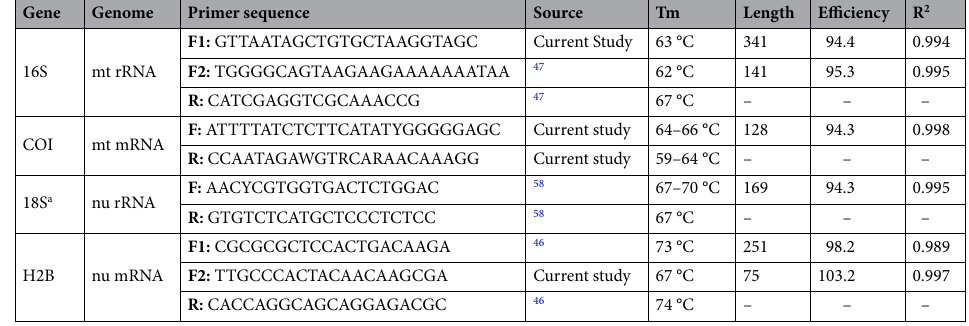
Table 1. Dreissenid specific primer pairs (F1-Forward 1, F2-Forward 2, and R-Reverse) used for quantitative PCR analysis of environmental DNA and RNA degradation. The genomic origin (mitochondrial (mt) or nuclear (nu)) and RNA types (ribosomal (r)RNA or messenger (m)RNA) are listed for each gene, as well as the length (base pairs), melting temperature (Tm), primer efficiency (%), and R 2 for each primer set. a Adopted from a primer set designed from loop-mediated isothermal